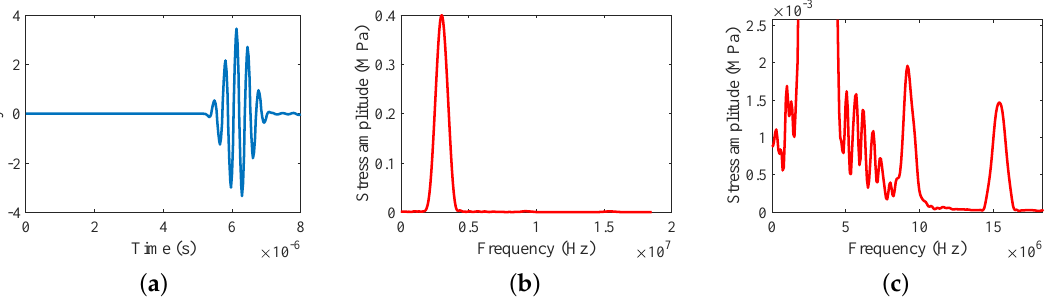
Figure 16. Simulation result of second order perturbation when C 2 = − 3 × 10 7 : ( a ) Time domain signal. ( b ) Spectrum of signal. ( c ) Harmonic of